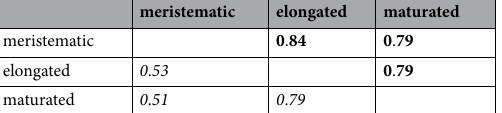
Table 3. Comparison of the predicted and the sampled flux distributions for the Li 2 scenario. For the extracted models flux values were randomly sampled for each model. The comparison of the models is conducted only based on the reactions shared between the models in each of the groups of coupled and decoupled to facilitate unbiased comparison of specificity. The comparison is based on the R v -coefficient which ranges between 0 and 1. Similar to the Pearson correlation an R v -coefficient of 1 means high similarity. Bold font indicates values corresponding to the decoupled models, whereas the italic font corresponds to the coupled